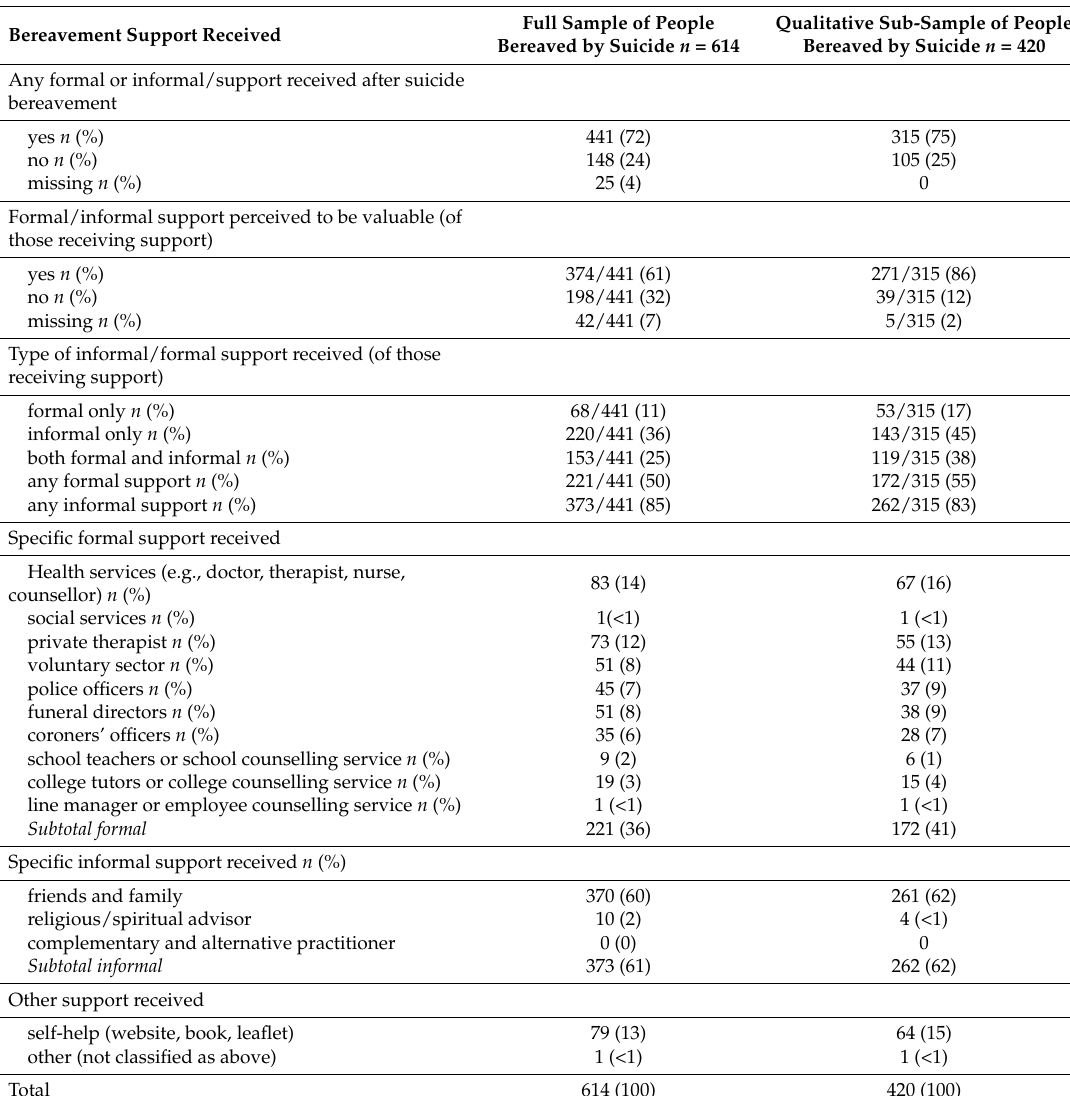
Table 2. Specific bereavement support